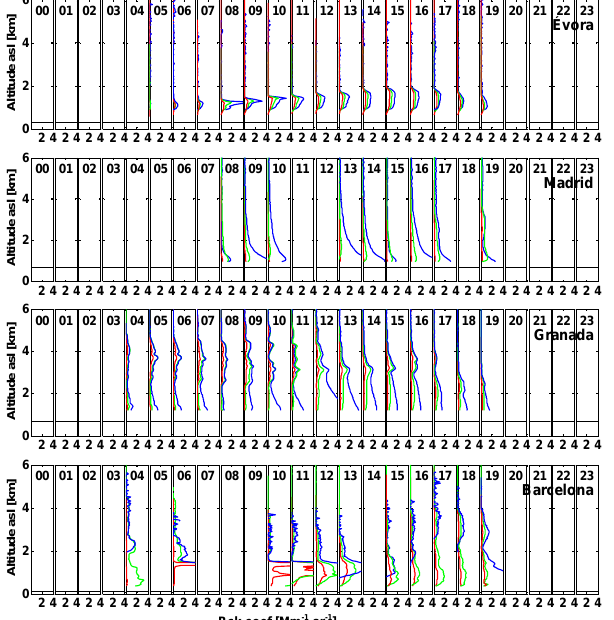
Figure 8. Idem as Fig. 7 at the central and eastern European stations ordered west to